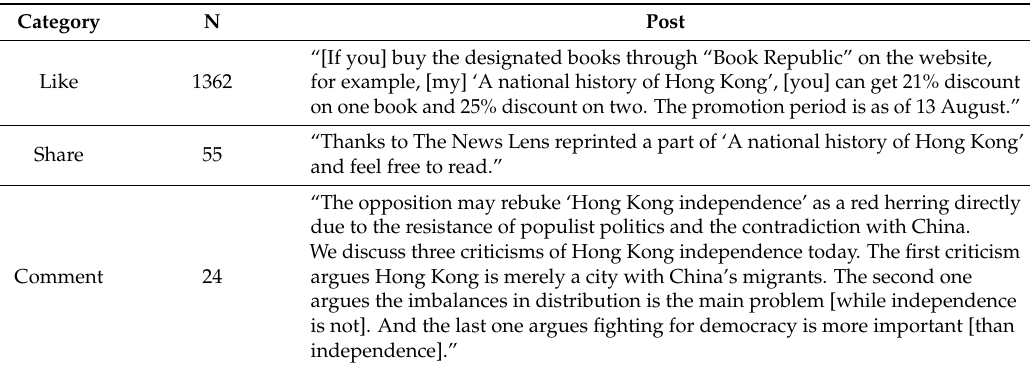
Table 4. The statistics of the most “likes”, “shares” and